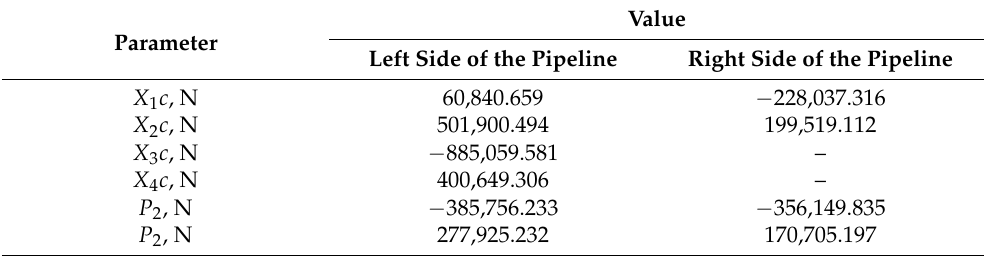
Table 4. Calculation results of the reaction forces that occur in the hydraulic cylinders of